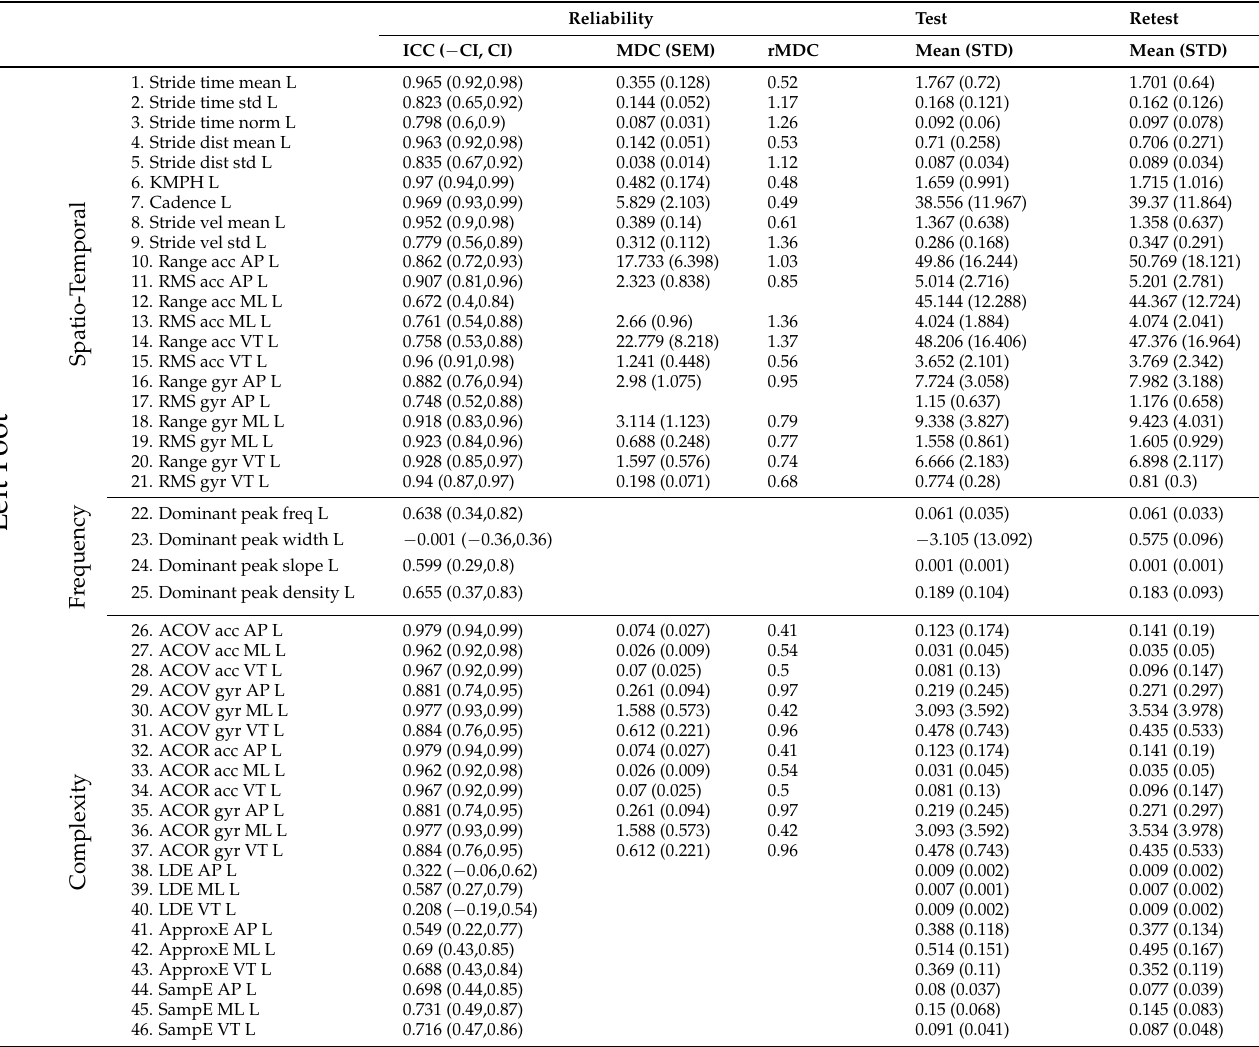
Table A1. Test–retest results of IMU-based gait assessment in people after